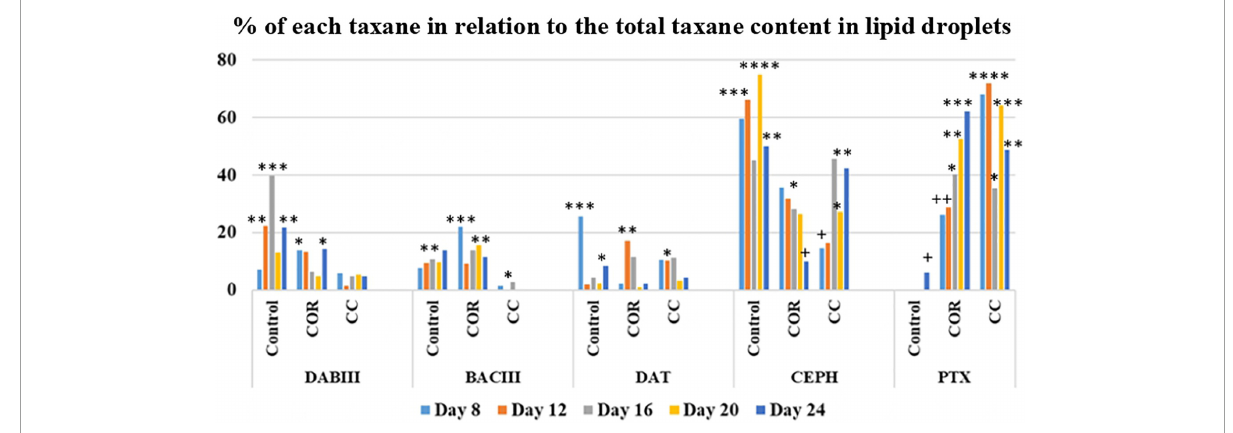
FIGURE8 Percentage of each taxane in relation to the total accumulated in the LDs, in T. baccata cell cultures when maintained for 24 days in the optimum medium for production complemented or not with elicitors. COR: 1 mM coronatine; CC: 1 mM coronatine + 50 mM β -CDs; DABIII: 10-deacetylbaccatin III; BACIII: baccatin III; DAT: 10deacetylpaclitaxel; CEPH: cephalomannine; PTX: paclitaxel. Values presented are means ± SD ( n = 3). Values followed by different symbols are significantly different ( P ≤ 0.05) according to Tukey’s honestly significant difference